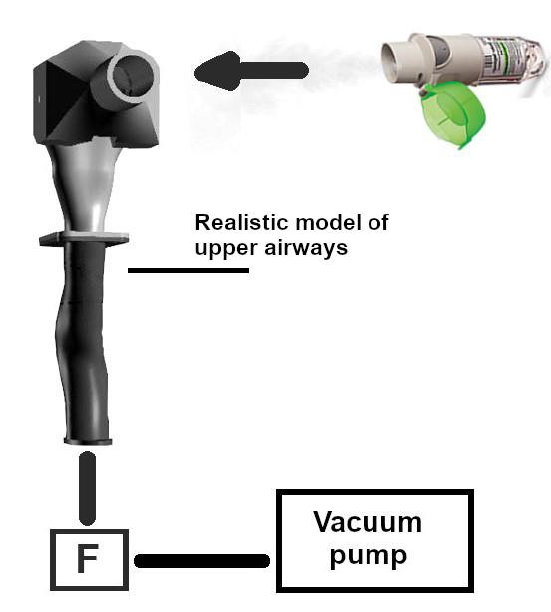
Fig. 2 : Scheme of the